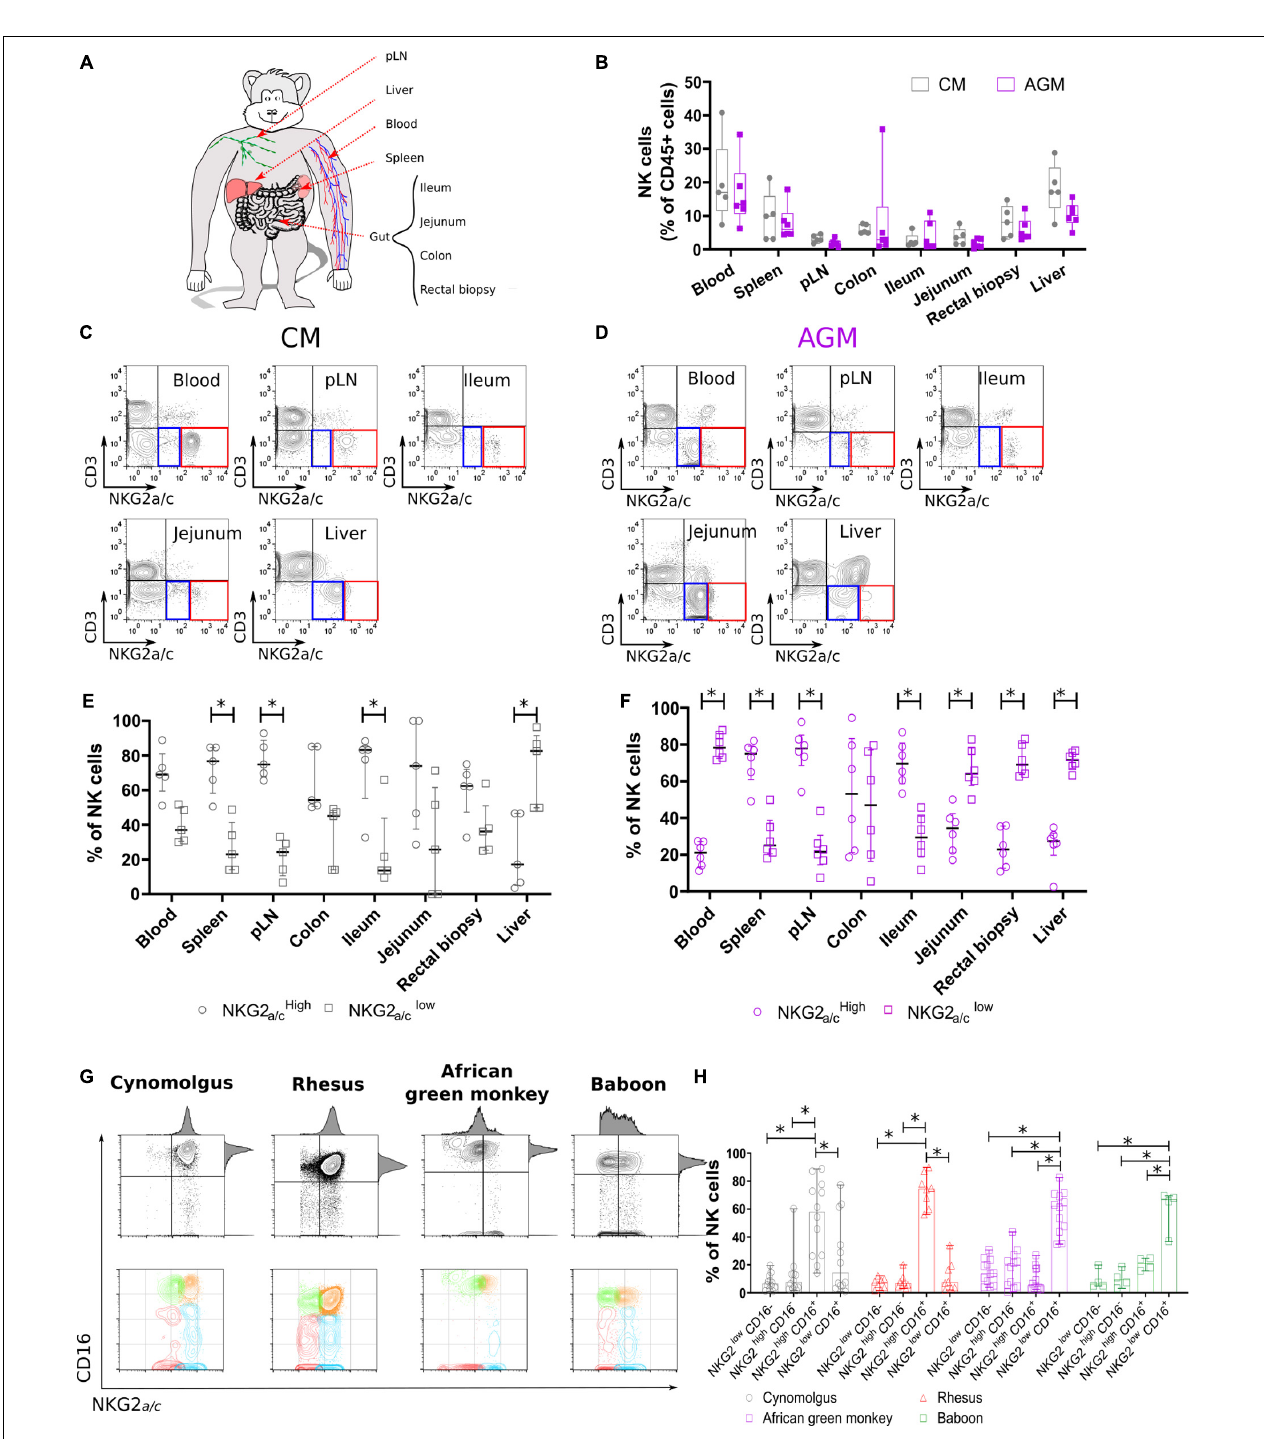
FIGURE 1 | Non-human primate NK cell subset distributions in tissues. (A) Scheme of the NHP tissues obtained and experimental workflow presented in this study. (B) NK cell distribution in distinct tissue compartments. Frequencies are shown in boxplots and correspond to compiled data from 5 SIV negative CMs (gray) and 6 SIV negative AGMs (purple). (C,D) Representative flow cytometry plots for NKG2a/c LOW (blue square) and NKG2a/c HIGH (red square) NK cell subsets in multiple tissue sites obtained from (C) CM and (D) AGM. (E,F) Distribution of NKG2a/c LOW (empty circle) and NKG2a/c HIGH (empty square) NK cell subsets in multiple tissue sites obtained from (E) five CMs and (F) six AGMs. (G) Representative dot plots showing blood NK cell subset distributions according to NKG2a/c and CD16 in four NHP species as indicated. (H) Frequency of blood NK cell subsets in four SIV negative NHP species. Each symbol depicts an individual animal among the 13 AGM, 12 CM, 7 RM, and 4 baboons. Median and standard error bars are shown. Statistical significance of differences was assessed using non-parametric Mann–Whitney U tests (B) , or Wilcoxon matched-pairs signed-rank test, for paired samples (E,F,H) . Asterisks indicate a p -value < 0.05.